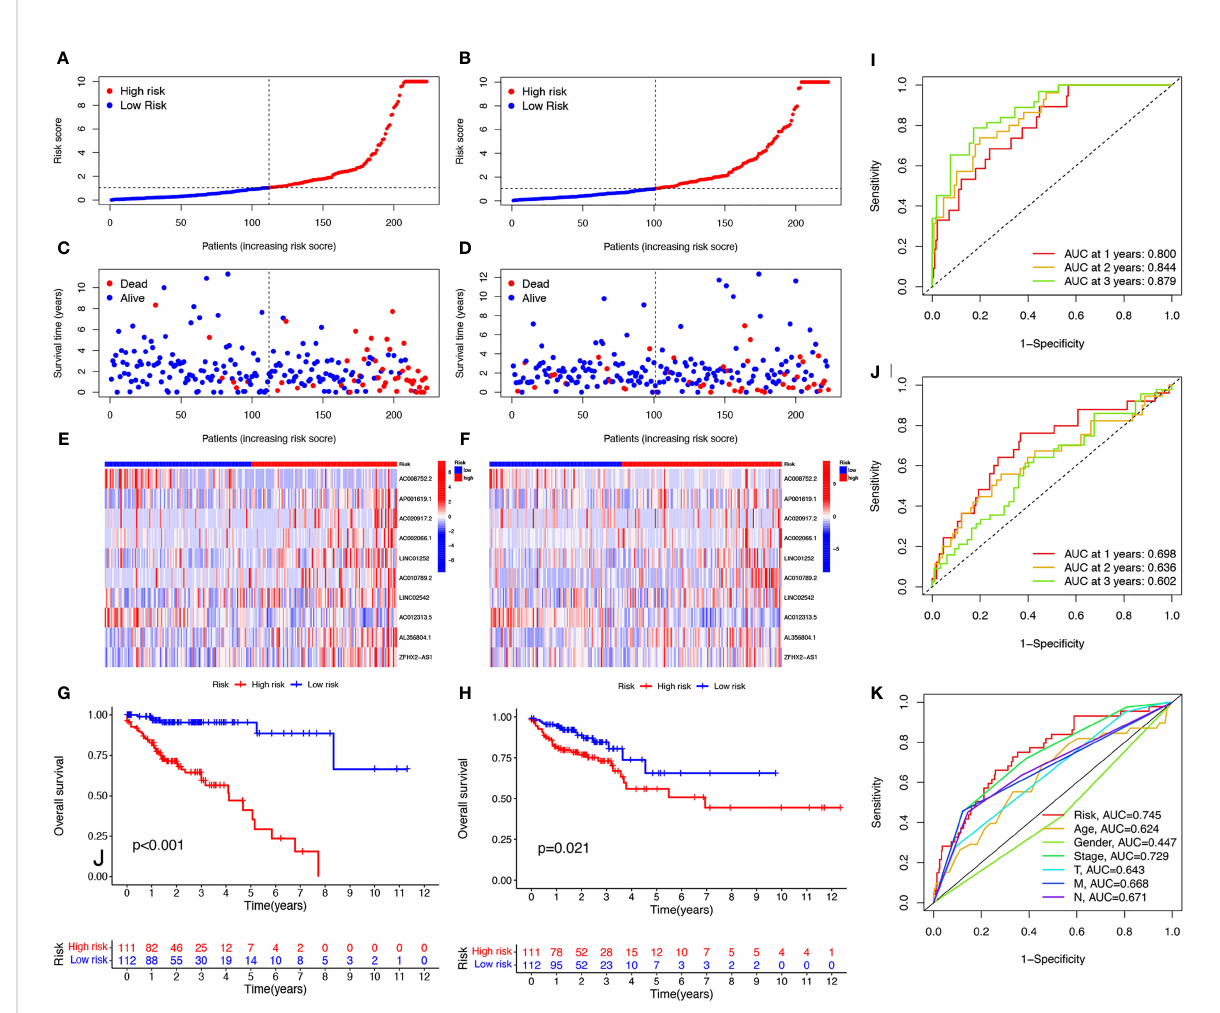
FIGURE 3 Evaluation of prognosis prediction ability of cuproptosis-related lncRNAs prognostic signature. Risk scores in the high and low-risk groups for the prognostic signature in COAD in the training set (A) and validation set (B) . Survival status of patients with COAD in high- and low-risk groups in the training set (C) and validation set (D) . Expression of the 10 cuproptosis-related lncRNAs in COAD in the training set (E) and validation set (F) . Survival analysis of the high-risk group and the low-risk group in the training set (G) and validation set (H) based on the TCGA dataset. ROC curve of the prognostic signature in the training (I) , validation (J) , and entire (K) sets. ROC curve, receiver operating characteristics curve; AUC, area under the curve; P<0.05, statistically signi fi